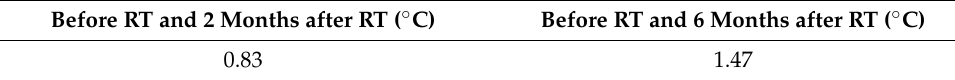
Table 2. Temperature differences between the patients before RT and 2 and 6 months after RT. Before RT and 2 Months after RT (°C)